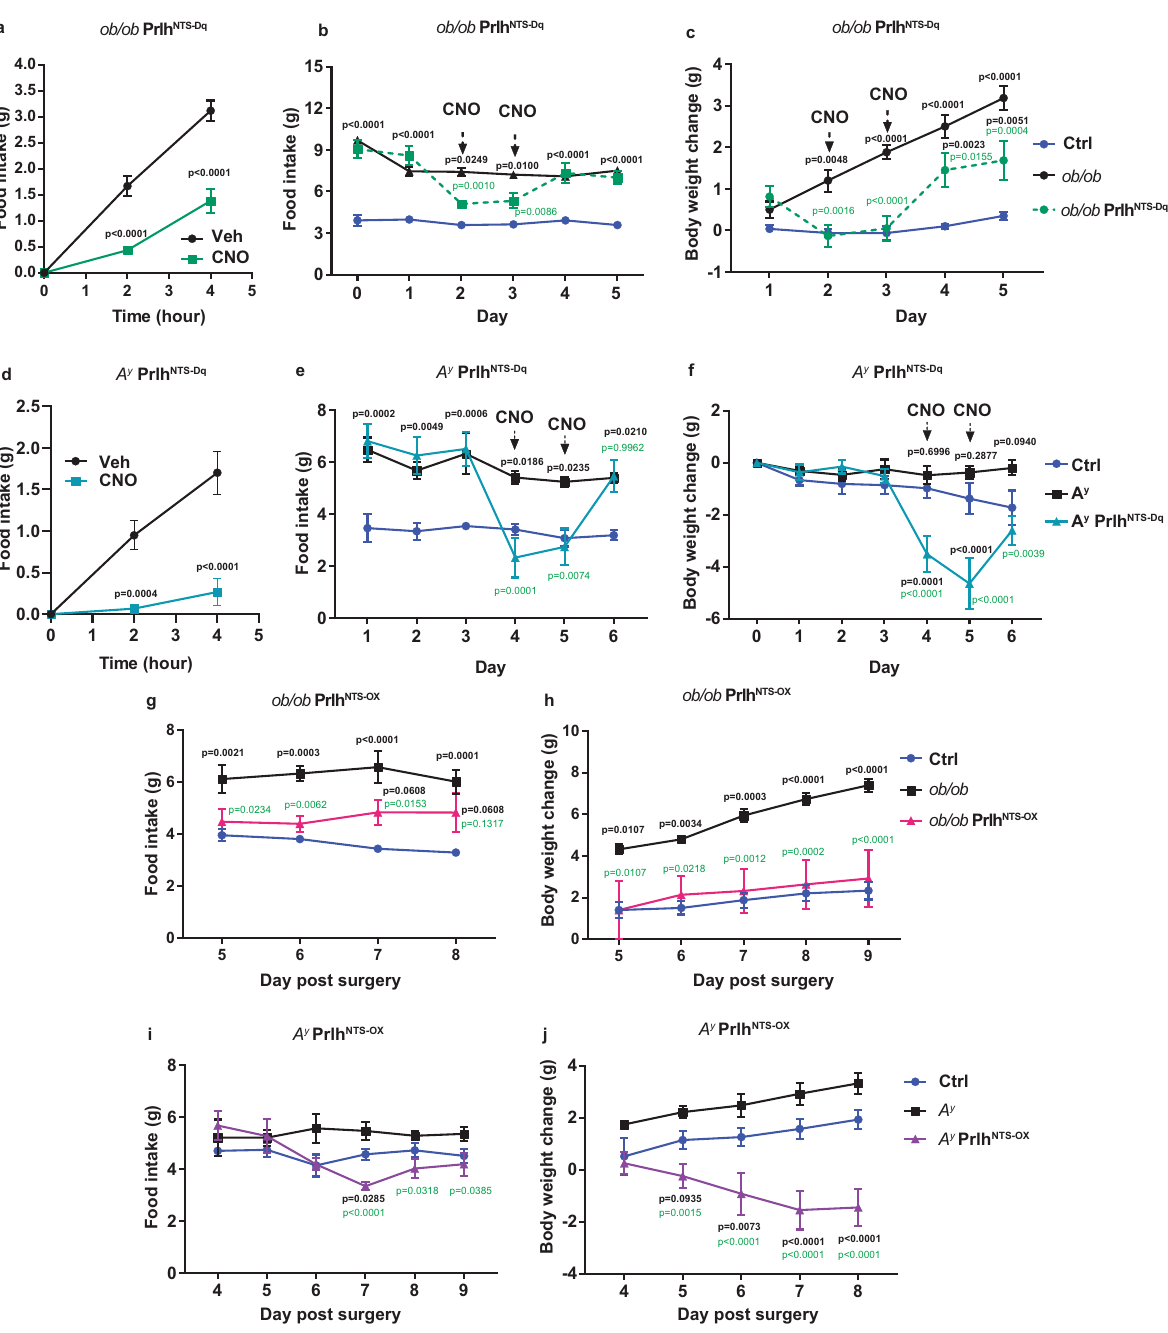
Fig. 6 Prlh NTS neurons and NTS Prlh block feeding and body weight gain in ob/ob and A y mice. A – F Acute food intake ( A , D ; n = 6 animals/group) and daily food intake ( B , n = 7 Ctrl animals, n = 6 ob/ob ;Prlh NTS-Dq animals, and n = 5 ob/ob animals, E , n = 6 animals/group) and body weight change ( C , n = 5 Ctrl animals, n = 6 animals per group for ob/ob and ob/ob ;Prlh NTS-Dq , F , n = 6 animals/group; compared to baseline days 0 – 1) for control (Ctrl) and Prlh NTS-Dq mice on the Lep ob/ob ( ob/ob ) or A y background treated with vehicle for two to three days, CNO (IP, 1 mg/kg; treatment days indicated in panels) for two days, and vehicle for another one or two days. Lean control mice are also included. G – J Daily food intake ( G , n = 5 animals per group, I , n = 7 Ctrl animals, n = 6 A y animals, and n = 5 A y ;Prlh NTS animals) and body weight change relative to day 0 ( H , n = 5 Ctrl animals, n = 6 animals/group for ob/ob and ob/ob ;Prlh NTS-OX , J , n = 7 Ctrl animals, n = 6 A y animals and n = 5 A y ;Prlh NTS-OX animals) for lean control (Ctrl) mice, ob/ob and ob/ob;Prlh NTS-OX mice ( G , H ) and A y and A y ;Plrh NTS-OX mice ( I , J ). Shown is mean + / − SEM. Two-way ANOVA, sidak ’ s multiple comparisons test was used. Signi fi cant or near signi fi cant p values for comparisons between control mice and ob/ob or A y groups shown in black; those for comparisons between ob/ob and ob/ob plus intervention or A y and A y plus intervention groups shown in green. All experiments were repeated in two independent cohorts of animals with similar results; cohorts were combined for